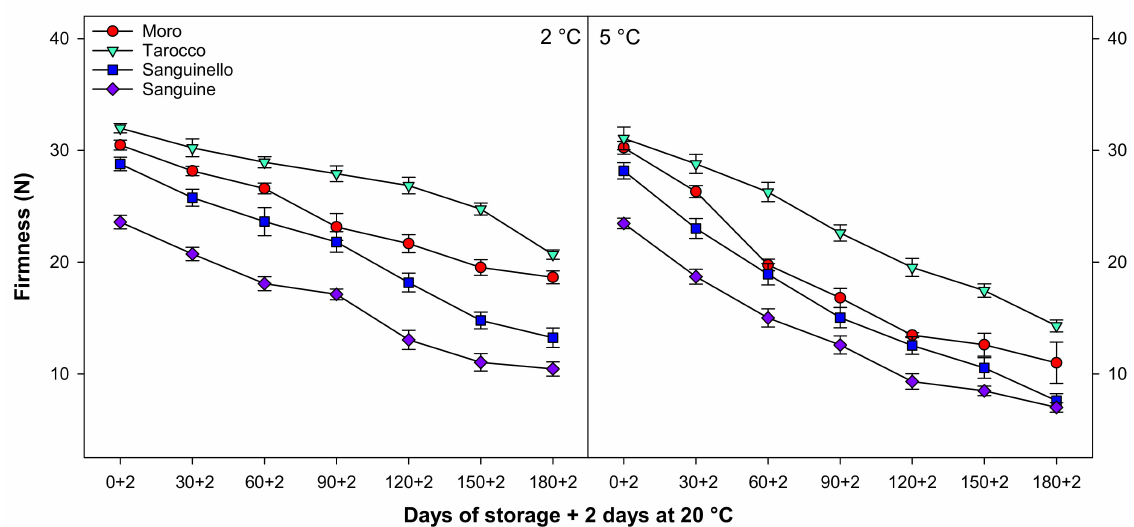
Figure 2. Changes in firmness of blood orange cultivars (‘Moro’, ‘Tarocco’, ‘Sanguinello’, and ‘Sanguine’) during cold storage at 2 and 5 ◦ C and 90% relative humidity (RH) plus 2 days at 20 ◦ C. Vertical bars represent ± standard error (SE) of means. LSD ( p < 0.05) value is